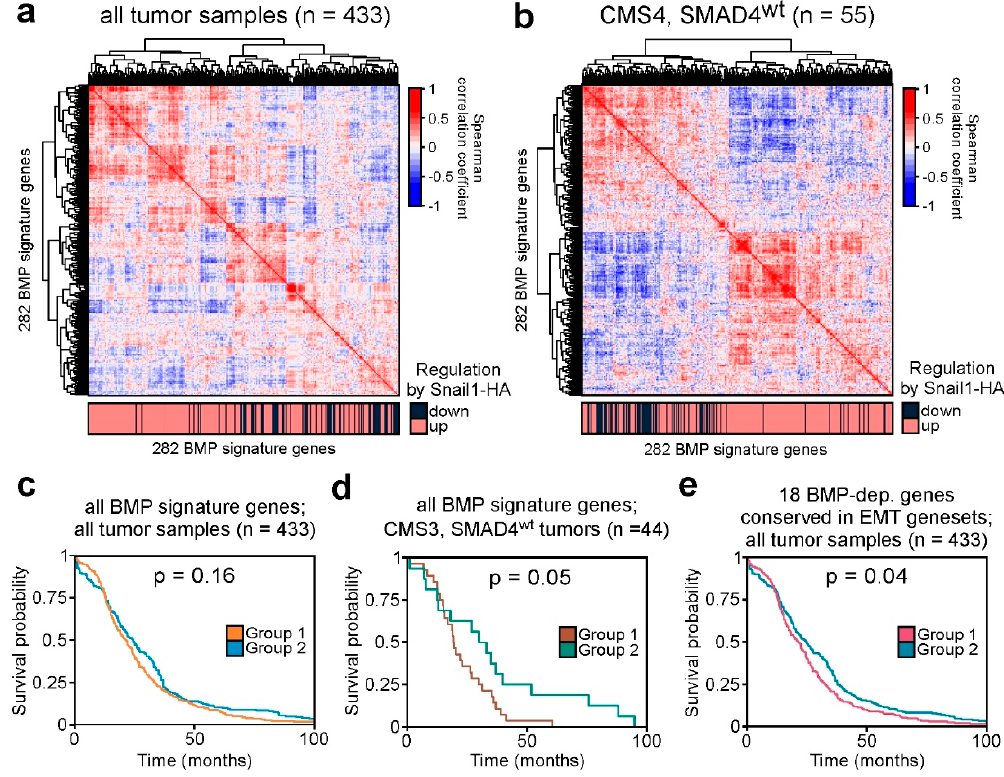
Figure 5. BMP signature gene expression is recapitulated in human colorectal cancer tumors and can be predictive for patient survival after tumor stratification. ( a ), ( b ) Correlation maps showing the mutual correlation of expression levels of all 282 BMP signature genes in transcriptomes of colorectal cancer (CRC) samples. Genes were clustered by unsupervised hierarchical clustering based on the Euclidean distance. In ( a ), all CRC samples available from TCGA were used. For ( b ), only the subset of tumors that classified as consensus molecular subtype (CMS) 4 and without mutations in SMAD4 ( SMAD4 wt ) was considered. The color bar on the bottom of each plot indicates whether a gene is up- or downregulated by Snail1-HA in LS174T cells. ( c – e ) Kaplan–Meier curves indicating survival probability of colorectal cancer patients. Patients were separated into two groups based on the expression of BMP signature genes in the tumors. In ( c ), all tumor samples and all BMP signature genes were used for the analysis. In ( d ), only the CMS3, SMAD4 wt tumors and, in ( e ), only 18 of the BMP signature genes conserved in significantly enriched EMT-related gene sets (see Figure 3c and Table S3) were considered. The corresponding clustering heatmaps are shown in Figure S7b–d. Log-rank test was applied